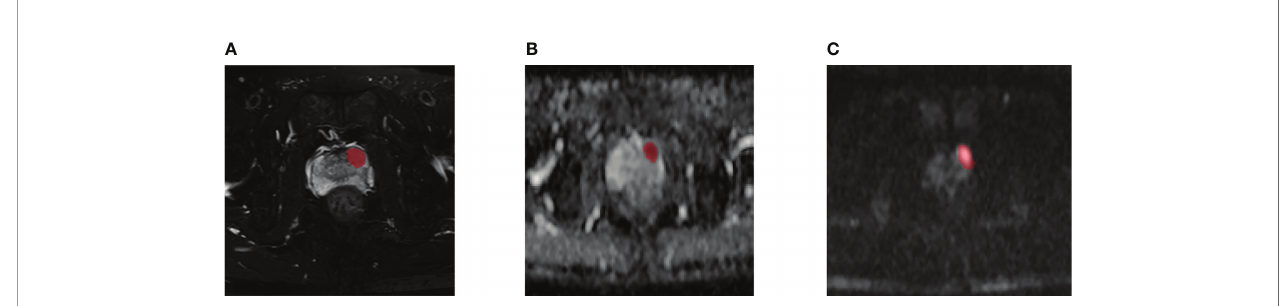
FIGURE 2 | A 59-year-old man diagnosed with csPCa in PZ (FPSA, 0.04 ng/mL; TPSA, 4.27 ng/mL; biopsy GS, 4 + 4 = 8). Example segmentations (red masks) of the tumor overlaid on axial T2-weighted fat-sat imaging (T2WI-fs) (A) , apparent diffusion coef fi cient (ADC) map (B) , and diffusion-weighted imaging (DWI) (C) .